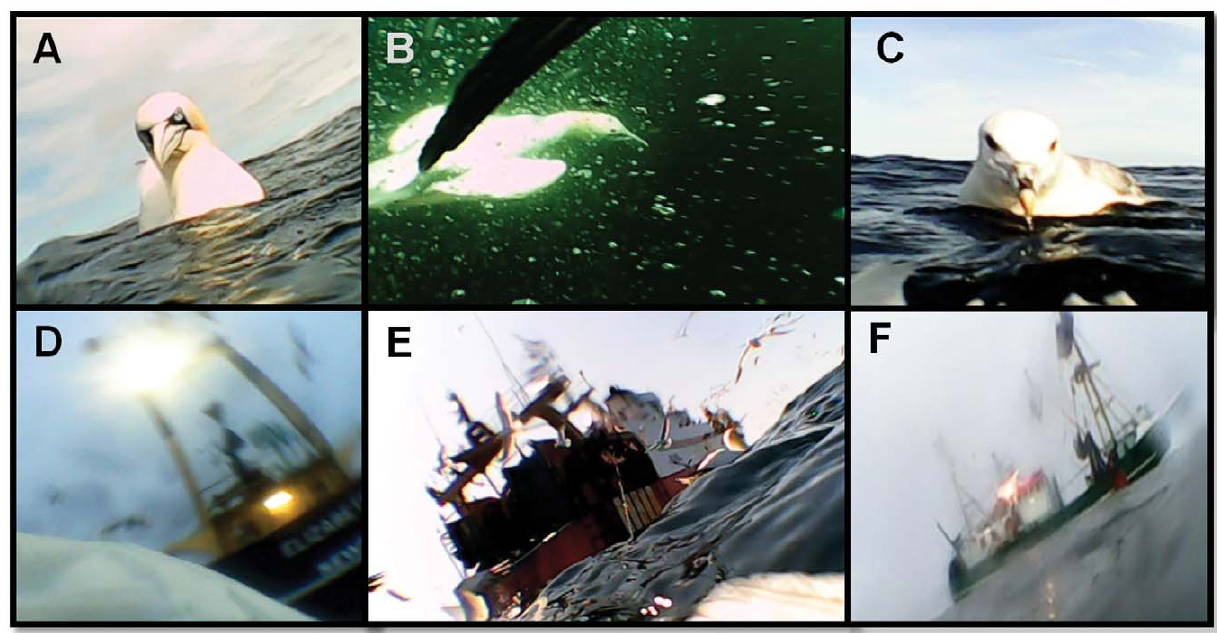
Figure 2. Bird-borne cameras reveal intra- and inter-specific interactions, and fishing vessel type. 93% of vessel encounters illustrated that northern gannets foraged with other birds, including conspecifics above (A) and below the water (B), as well as northern fulmars ( Fulmarus glacialis ) (C). Fishing vessels were visited during crepuscular foraging (D). The vast majority (95%) of fishing vessels encountered were trawlers, including stern trawlers (E) and beam trawlers (F).